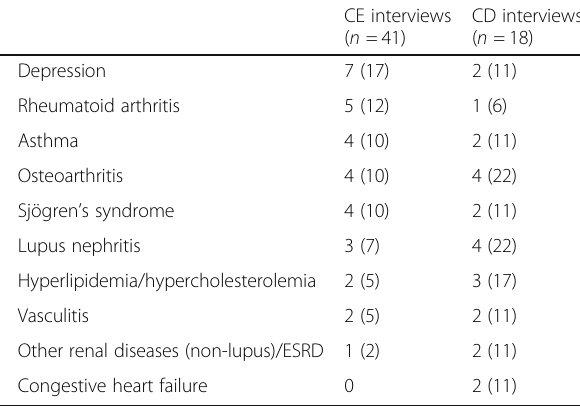
Table 2 Demographic and clinical characteristics of patients